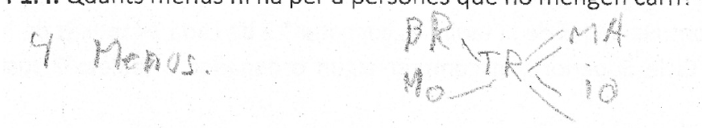
10 of 17 Figure 7. Incorrect answer of Q3. SPC1 error (translation: it would be three desserts). On the other hand, in the same way as in the previous questions, the CC1 error is explicitly observed or deduced in those answers that only show a number. Specifically, the students add a certain amount, which can be 1 or 3, to the number of possible menus they have found in Q2. While the 1 refers exclusively to the banana dessert, the 3 is the cardinal of the des- sert dishes that there would be when adding this third option. It should be noted that this strategy has also been used in some cases in which the answer to Q2 is correct. There are other incorrect numerical answers in which the strategy does not appear explicitly, but it is intuited that, behind it, there is an error of the type PC1, in which the